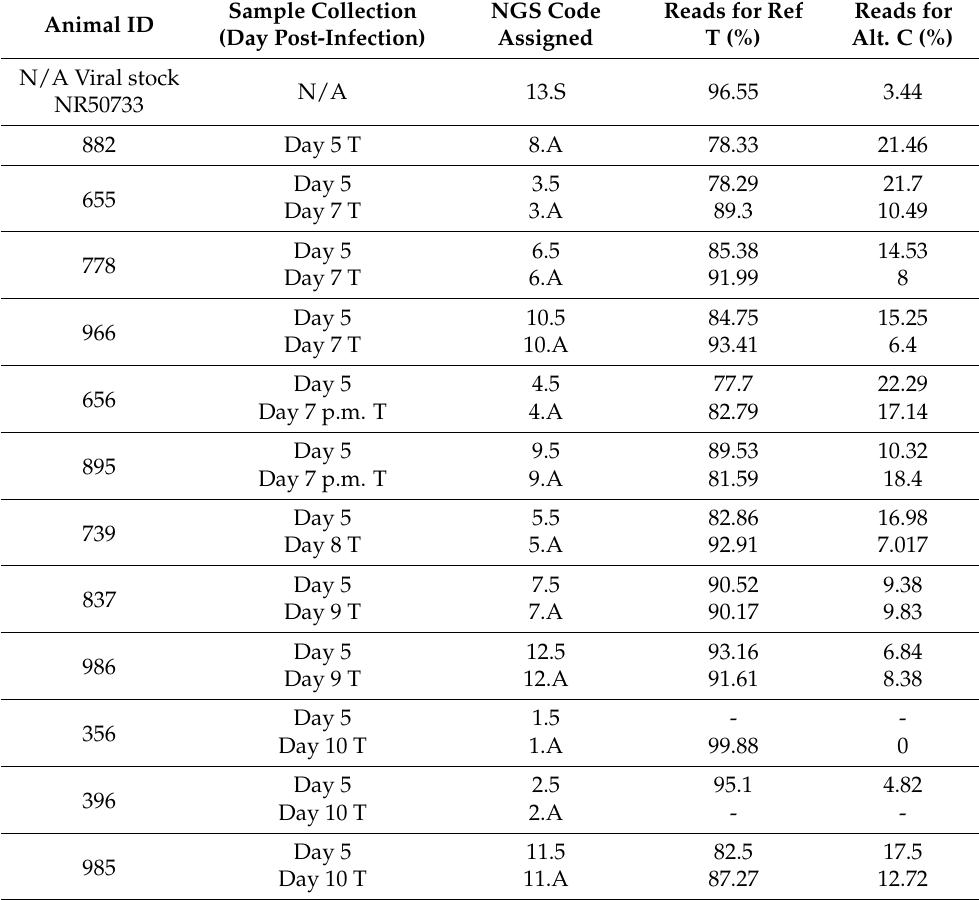
Table 3. Percentage of reads containing alternative base at location 2609.